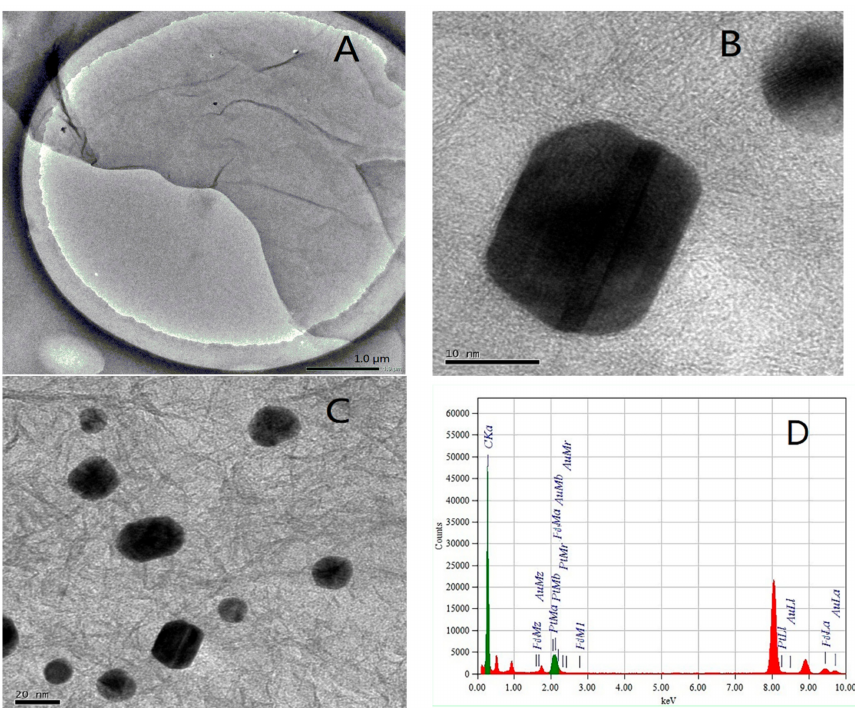
Figure 1. Transmission electron microscopy (TEM) images of ( A ) graphene oxide (GO) with scale bar of 1.0 µ m, ( B , C ) BLG-PtAuPd-RGO with scale bar of 10 nm and 20 nm; electron-dispersive X-ray (EDX) spectrum ( D ) of BLG-PtAuPd-RGO